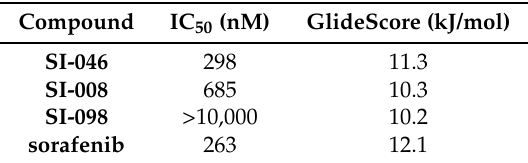
Figure 5. Selected compounds from the focused library based upon the pharmacophore 4-PAPU. PAP is colored red and unsymmetrically disubstituted urea is colored green. Molecular formula, molecular weight, and CLogP are generated with ChemDraw. Table 1. BRAF V600E inhibitory activity and GlideScore of selected compounds from the focused library based upon the pharmacophore 4-PAPU.